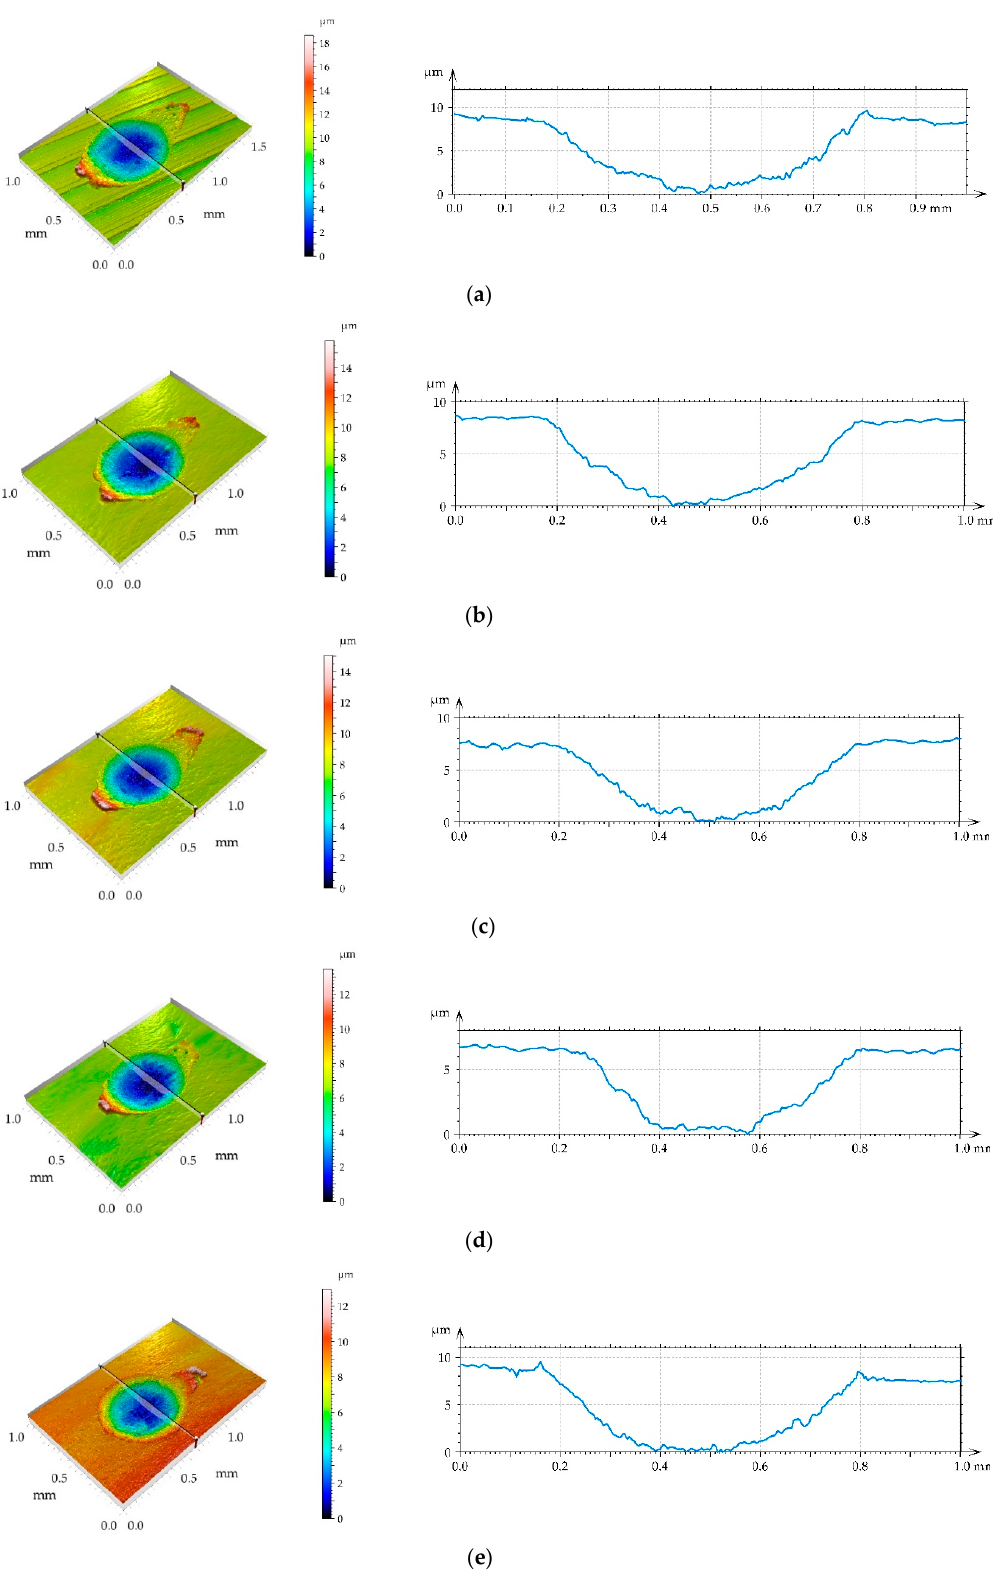
Figure 9. Isometric views of disc surfaces and profiles orthogonal to wear scars at a normal load of 50 N, ( a ) milled sample, ( b ) burnished samples for pressure of 10 MPa, ( c ) 20 MPa, ( d ) 30 MPa, ( e ) 40 MPa.